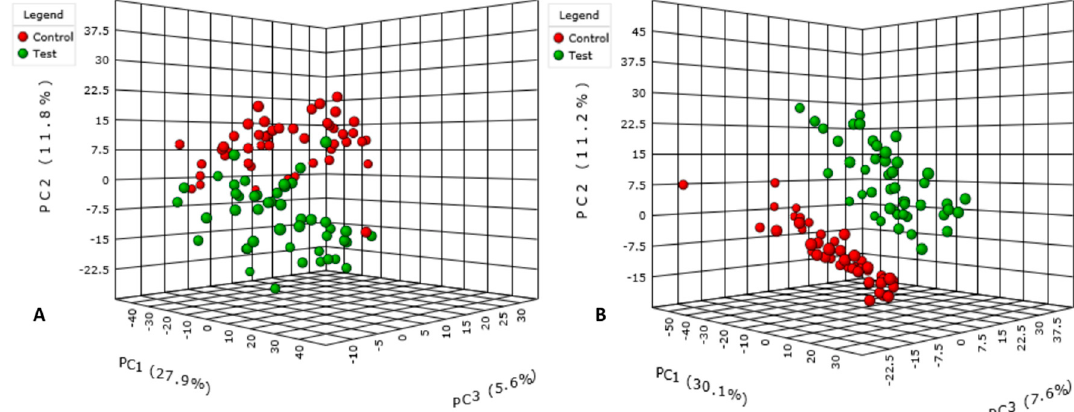
Figure 2. PCA 3D score plot analysis of human urine before (Control) and after (Test) consumption of genipap juice in positive ( A ) and negative ( B ) mode. The analysis was performed using MetaboAnalyst 3.5.